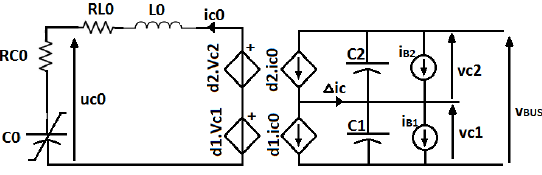
Figure 9. Large-signal average model of 3-level DC/DC converter [47].